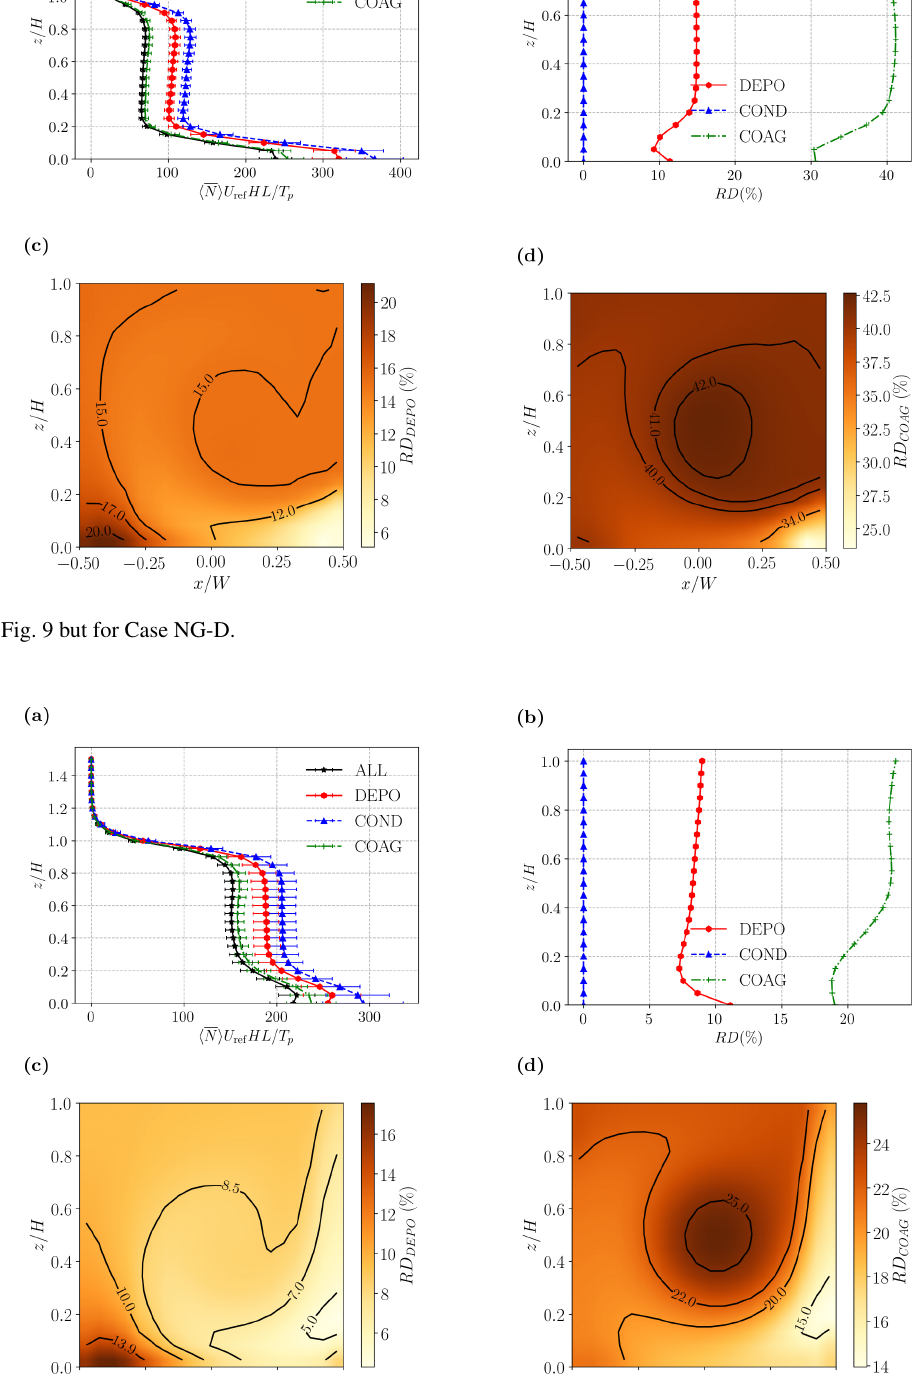
https://doi.org/10.5194/acp-22-2703-2022 Atmos. Chem. Phys., 22, 2703–2726,